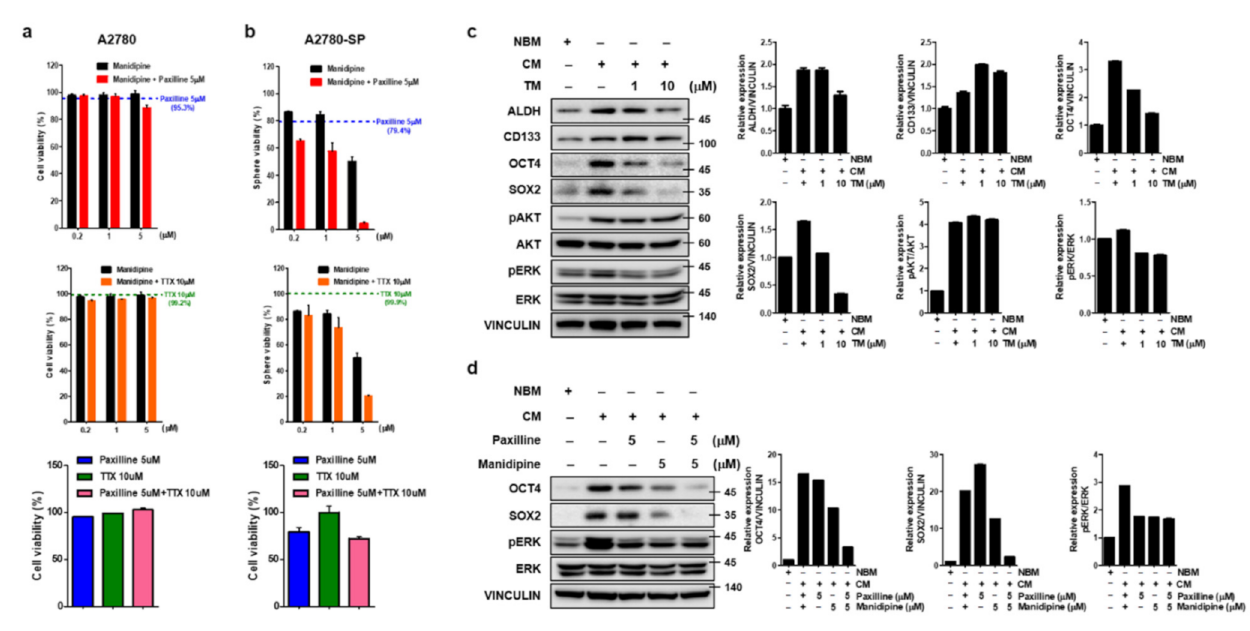
Figure 3. Simultaneous inhibition of BKCa and calcium channel in ovarian CSCs enhances cell death and further reduces stemness. ATP-based cell viability of ( a ) A2780 and ( b ) A2780-SP cells measured when the calcium and BKCa channels were simultaneously inhibited by co-treatment with 0.2, 1, or 5 µ M manidipine (calcium channel blocker) and 5 µ M of paxilline (BKCa channel inhibitor), and compared to the cell inhibition resulting from treatment with manidipine alone. ATP-based cell viability was measured when the calcium and sodium channels were simultaneously inhibited by co-treatment with 0.2, 1, or 5 µ M manidipine (calcium channel blocker), and 10 µ M of TTX (sodium channel blocker), and compared to the cell inhibition resulting from treatment with manidipine alone. ATP-based cell viability when the BKCa channel and sodium channels were simultaneously inhibited was measured by cotreatment with 5 µ M of paxilline and 10 µ M of TTX compared to individual treatments. ( c ) TM was applied to A2780-SP cell CSC culture on CM media for 24 h and cell lysates were collected. The expression level of stemness-related markers (ALDH, CD133, OCT4, and SOX2) and the phosphorylation level of AKT and ERK were analyzed by Western blot. Vinculin was used as a loading control for the cell lysates. ( d ) BKCa and calcium channels were simultaneously inhibited by co-treatment with 5 µ M of paxilline and 5 µ M of manidipine for 24 h on A2780-SP cell CSC culture with CM media. Cell lysates were collected and the expression levels of OCT4 and SOX2 and the phosphorylation level of ERK were analyzed by Western